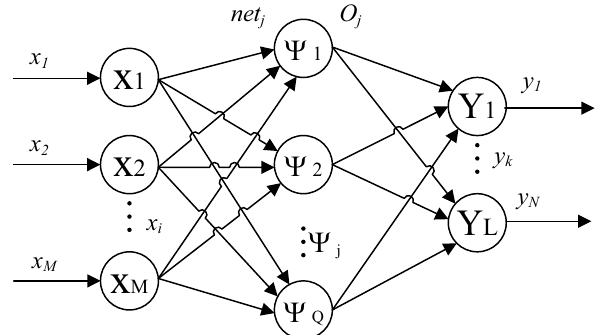
Figure 2. Structure of WNN. From left to right, there is an input layer, a hidden layer, and an output layer. net represents the inputs of hidden layer and O represents for the outputs of hidden layer. (cid:31) represents the wavelet function (activation